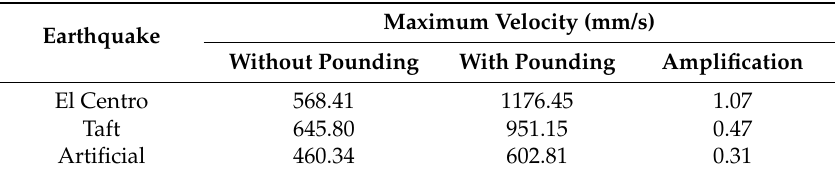
Table 6. Maximum velocity values for model A.